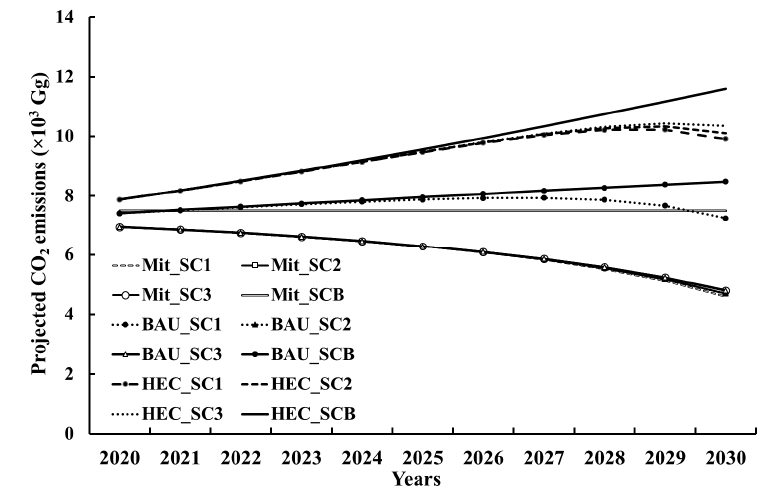
ff erent CO Figure 3 Figure 3. Comparison of di 2 emission scenarios for passenger vehicles in Gauteng